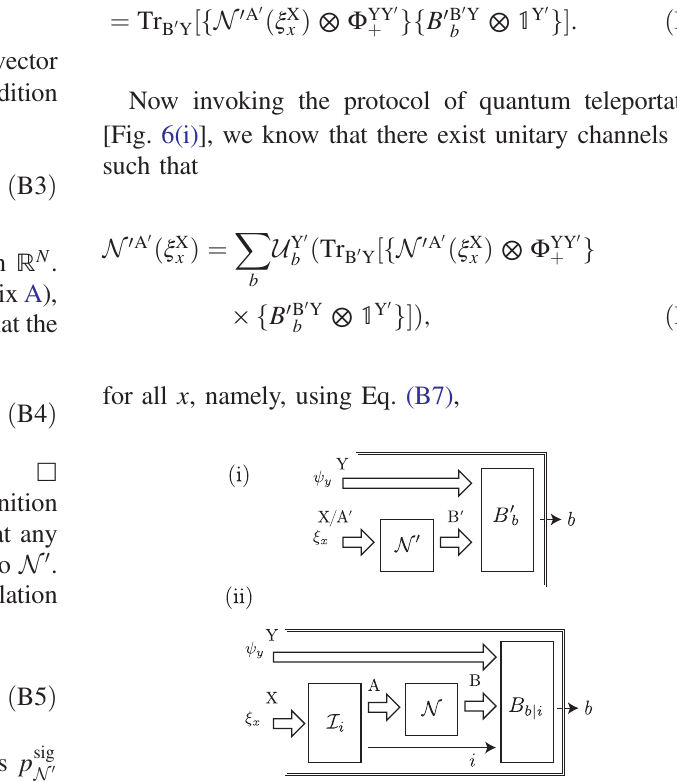
FIG. 5. A diagram relating the uses of the channels N and N 0 to produce the signature correlation of N 0 in Eq. (B6). The correlations of both boxes enclosed in double lines are identical, and thus their behavior is essentially